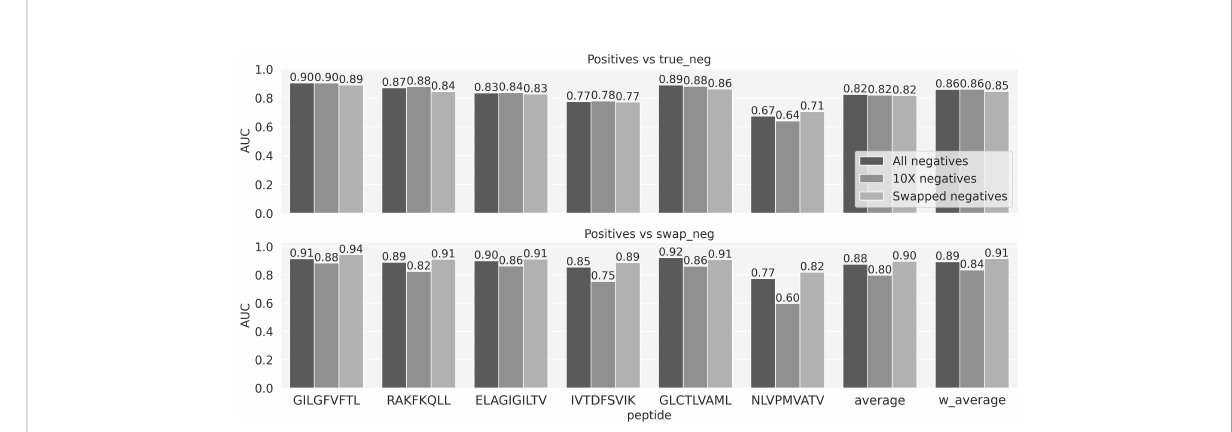
AUC calculated on the positive vs swapped negative prediction task (Figure 4, lower panel) compared to positives versus true negatives (Figure 4, upper panel). Except for the GLC peptides, the model trained on all the CDRs signi fi cantly outperforms the one trained on CDR3 only (p-value<0.001, based on a bootstrap test with 1000 resampling with replacement) across all the peptides, when looking at the positives versus swapped negatives prediction. AUC01 and PPV comparisons are shown in Supplementary Figure 4.